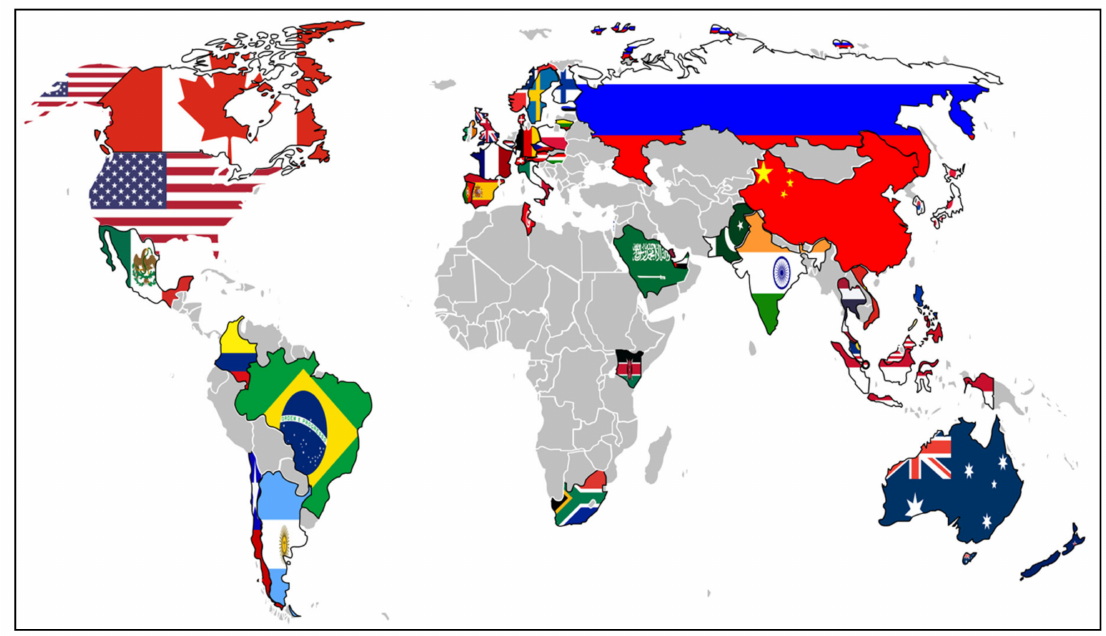
Figure 3. Countries with a national AI strategy, derived from Holon IQ